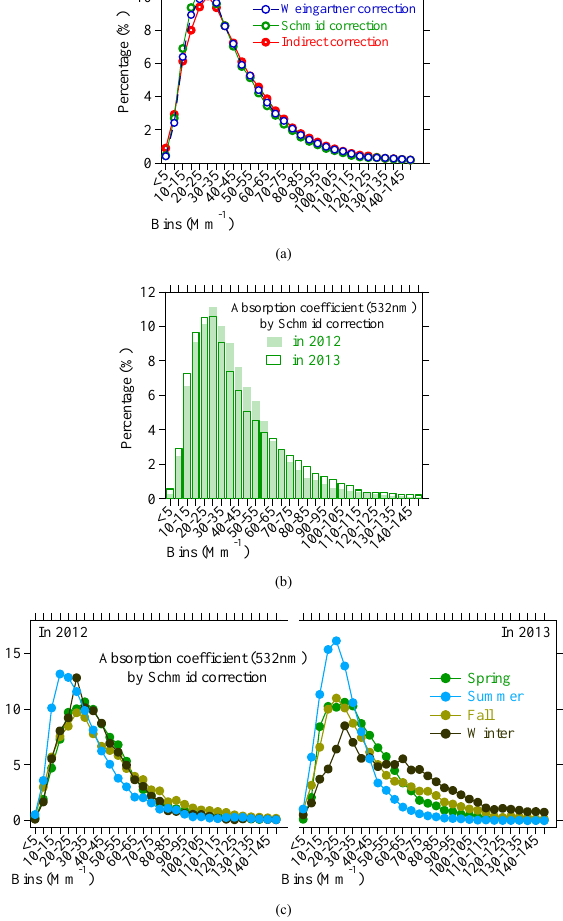
Figure 4. Diurnal variations of the aerosol absorption coefficients at 532nm in the urban area of Nanjing. Panel (a) shows the 2-year (2012–2013) coefficients corrected by IDC (red), WC2003 (blue), and SC2006 (light green); and (b) shows the coefficients corrected by SC2006 in separate seasons of 2012 and 2013. March, April, and May represent the spring; June, July, and August represent the summer; September, October, and November represent the fall; and January, February, and December in 2012 (2013) represent the win- ter in 2012 (2013).